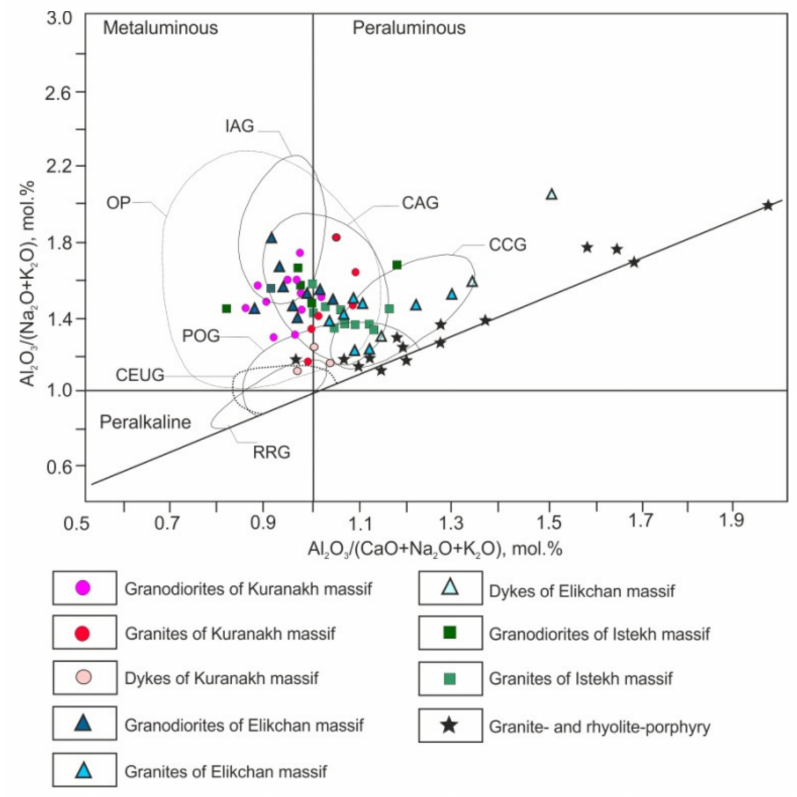
Figure 8. Al 2 O 3 /(Na 2 O + K 2 O)–Al 2 O 3 /(CaO + Na 2 O + K 2 O) diagram for granitoids [78]. Granitoid fields include: IAG—island arcs; CAG—continental arcs; CCG—continental collision settings; POG—postorogenic; CEUG—continental epirogenic uplifts; and